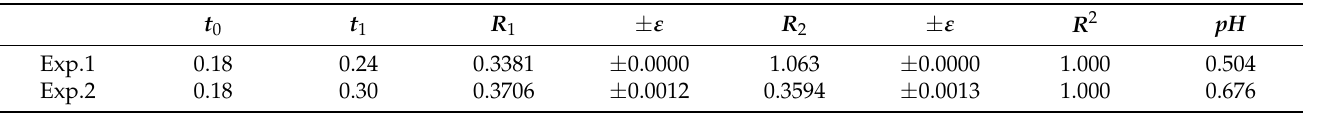
Table 8. Logarithm model parameters estimated by minimizing the mean absolute errors with experimental data 1 (see Figure 12).